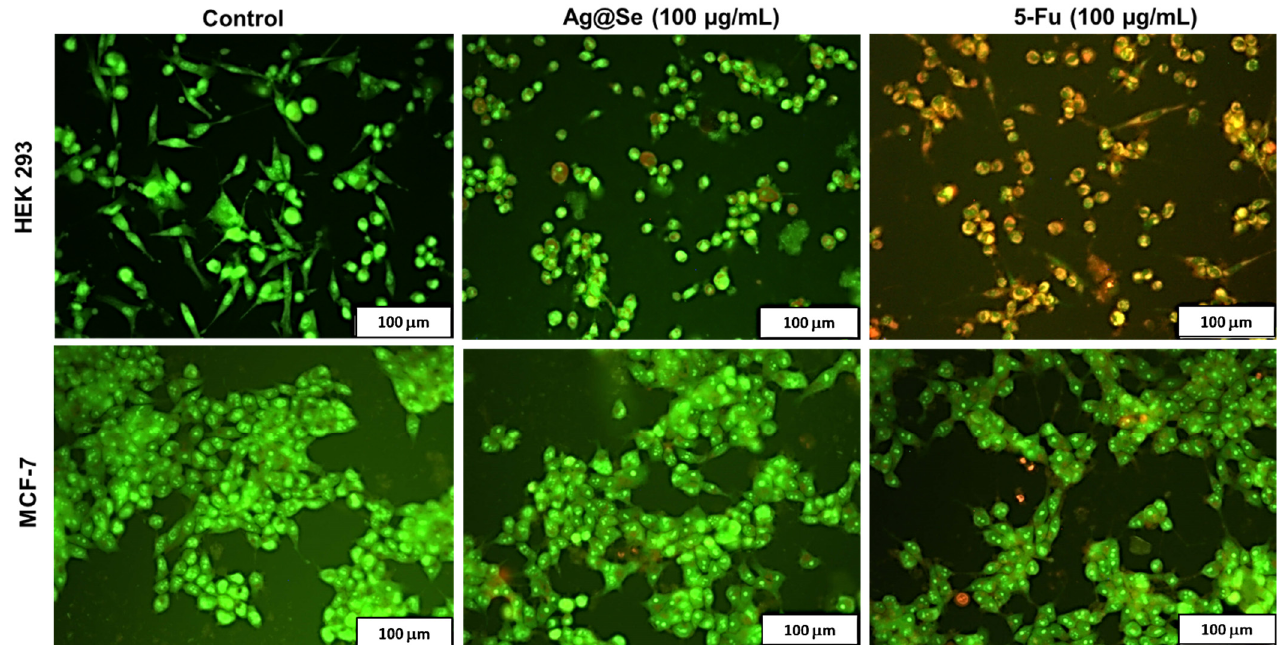
Figure 6. Fluorescent images of acridine orange/ ethidium bromide dual stained human embryonic kidney (HEK 293) and breast adenocarcinoma (MCF-7) cells. Green fluorescence denotes viable cells, dark red denotes necrotic cells, yellow to orange denotes cells undergoing late apoptosis, while yellow-green nuclei denote early apoptotic cells. Scale bar = 100 µm.